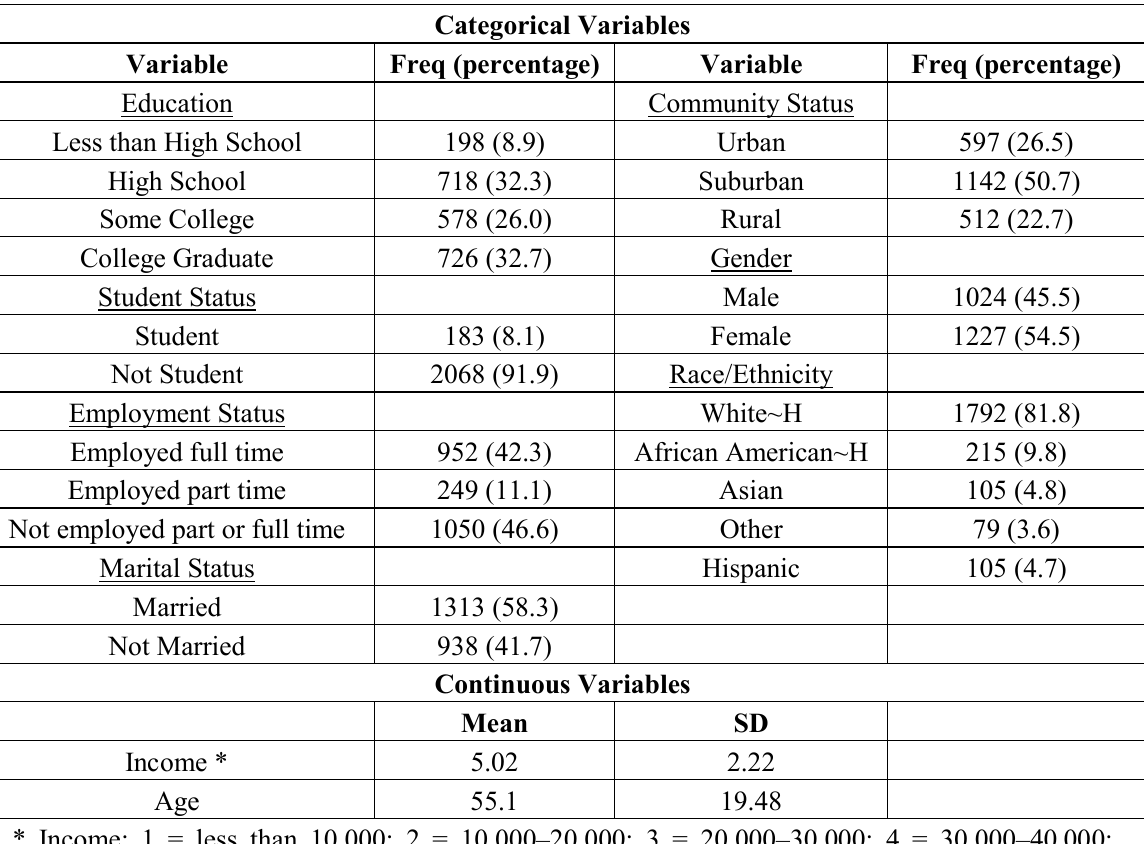
Table 1. Univariate statistics for independent variables.